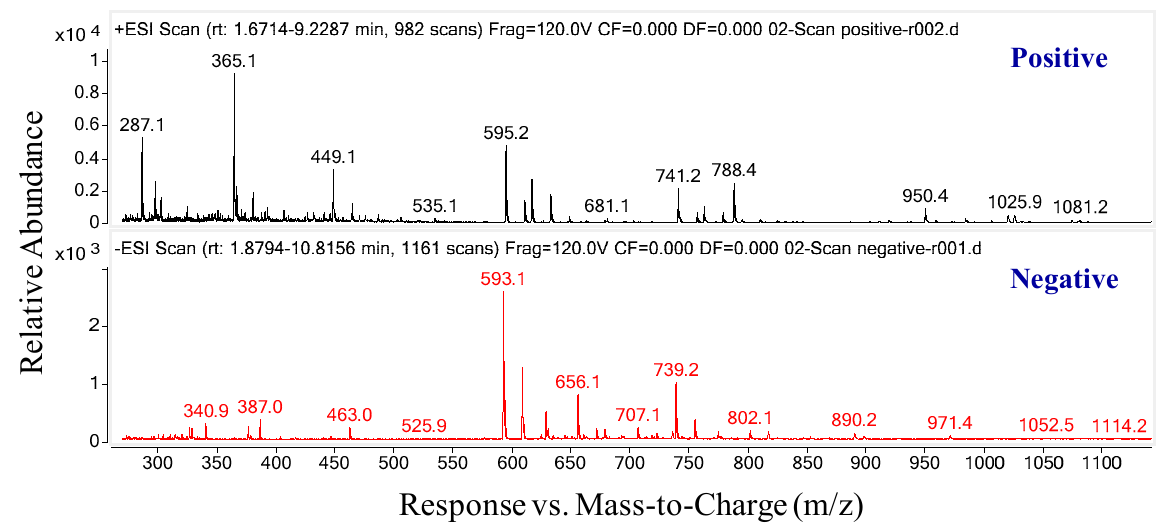
Figure 2. Total ion spectra in positive and negative modes.